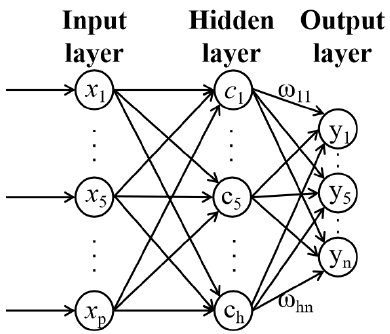
Figure 2. RBF neural network structure.